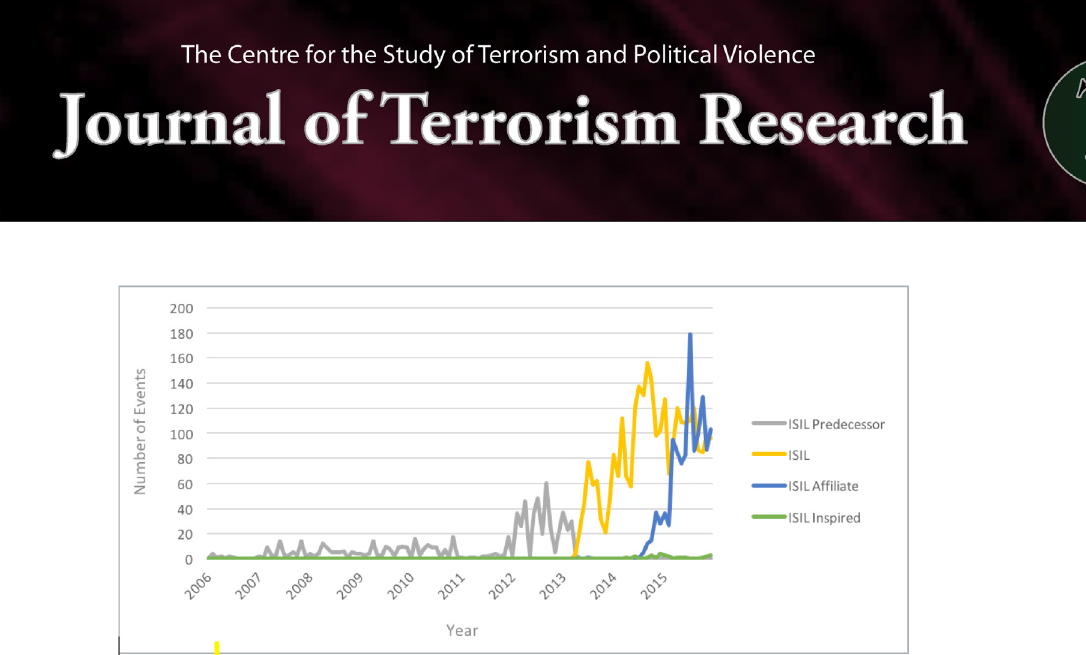
Figure 1. Attacks carried out by ISIS/ISIL, its predecessors and affiliates between the years 2006 and 2015. (data taken from the Global Terrorism